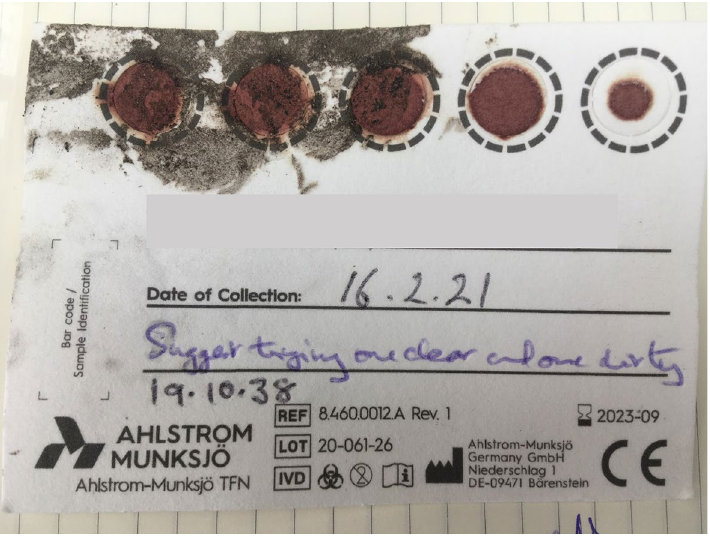
Figure 5. Impact of a wet and muddy canine foot upon a DBS from a recipient of a first dose of Pfizer vaccine. This exemplifies the damage accidently inflicted by a dog’s muddy paws on a DBS sample which had been laid out to dry. Eluates from the imprinted spots produced a valid strong positive Ig capture result.